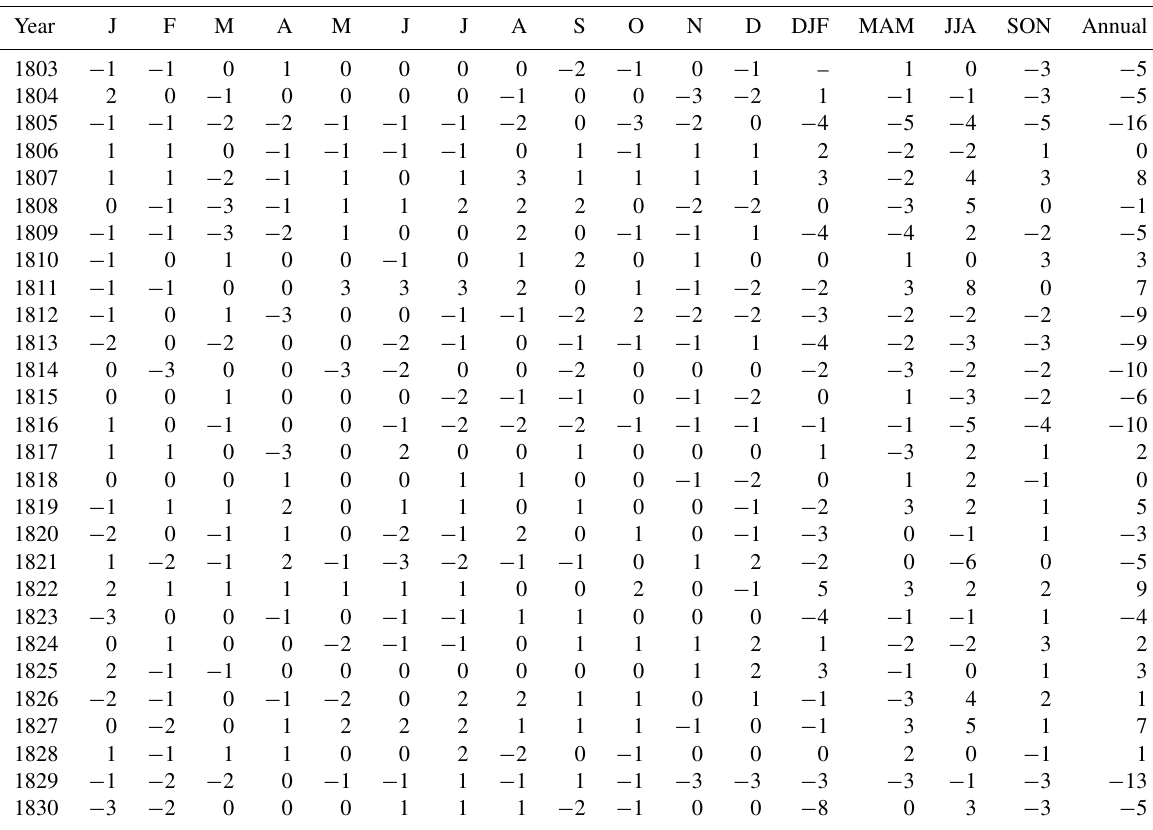
Table 1. Weighted 7-degree temperature indices reconstructed from the daily weather records kept by Šimon Hausner in Buchlovice, 1803–